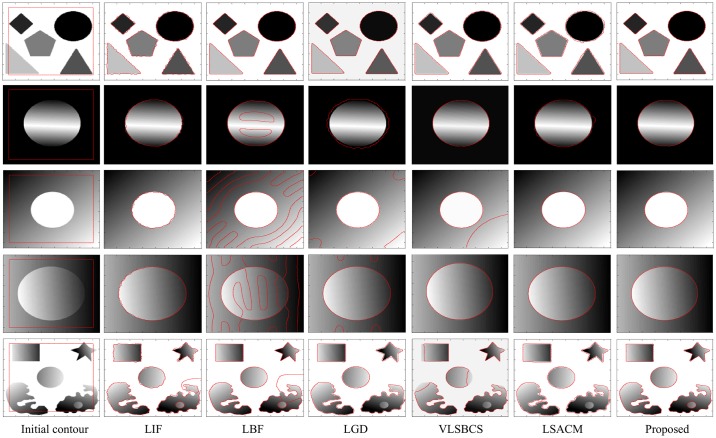
Segmentation results using images with different homogeneity and inhomogeneity possibilities.